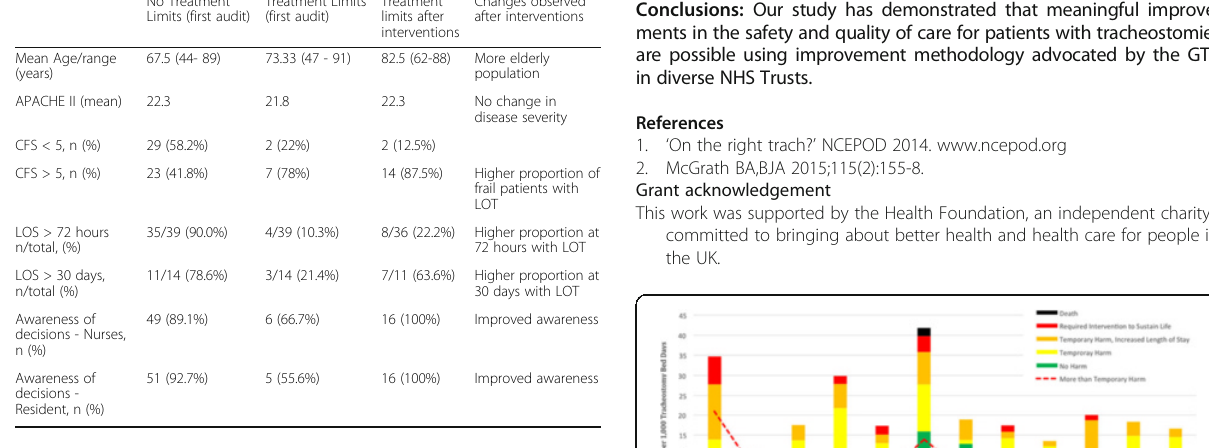
Table 25 (abstract A45). Results overview from the audit cycle No Treatment Treatment Limits Limits (first audit) (first audit)